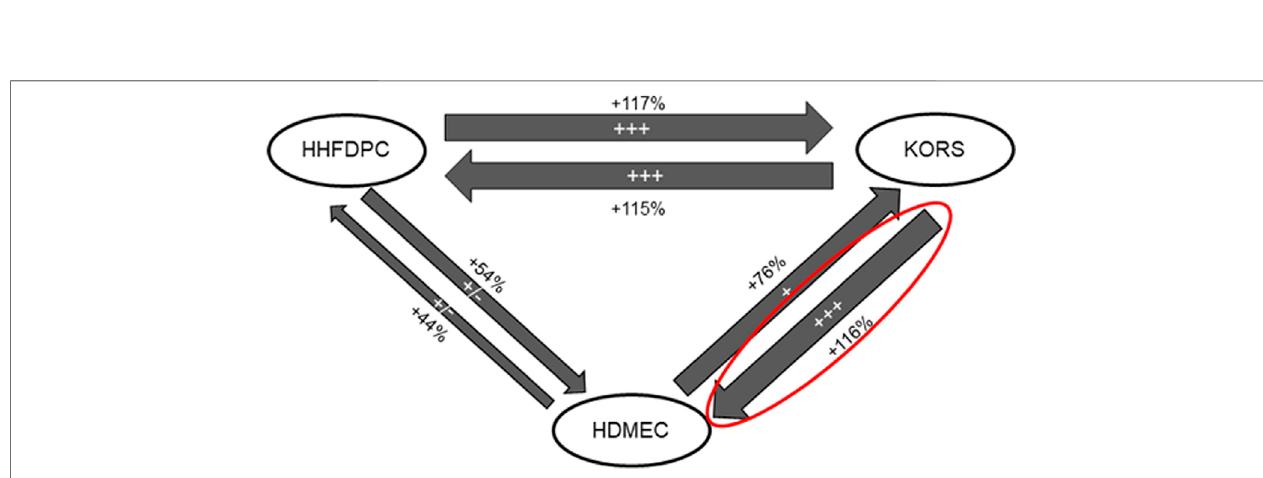
further a supplementary fi gure ( Supplementary Figure S2 ) was added showing the graphs corresponding to the reciprocal effects of the 3 cell types in proliferation assays.